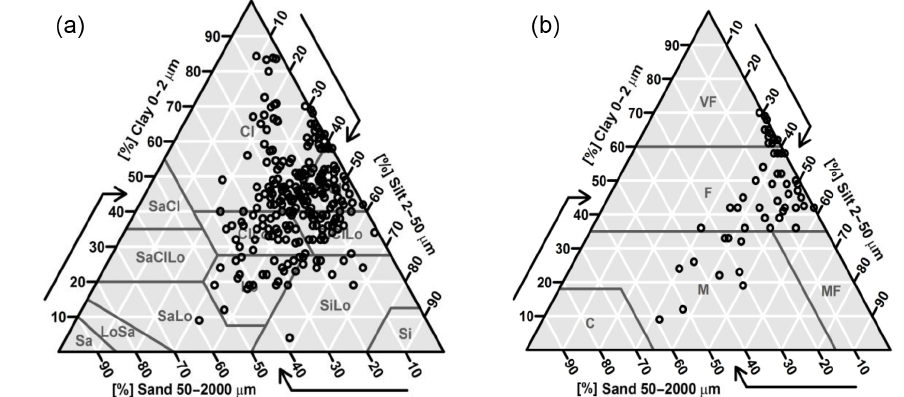
Figure 1. (a) Texture fractions of the dataset (242 samples), based on the USDA system. (b) Particle size distribution of 53 soil samples from Algeria according to the FAO textural triangle (FAO,